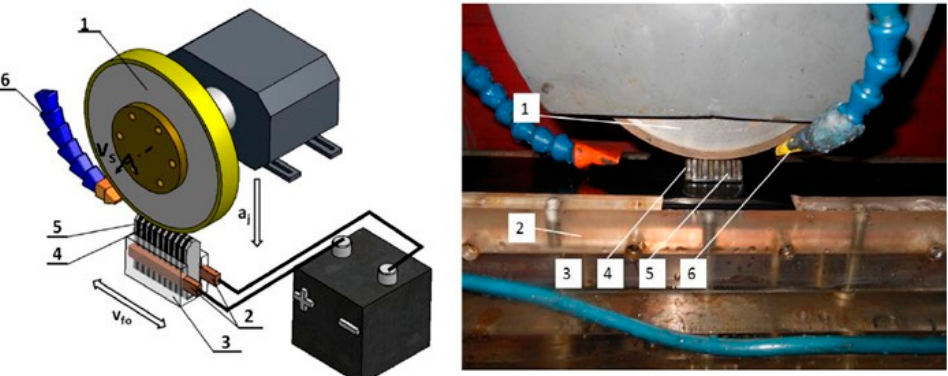
Figure 4. Diagram and view of the system for electrodischarge dressing of superhard grinding wheels with a segmental electrode: 1—grinding wheel, 2—copper graphite brush supplying voltage from the generator to the electrode, 3—vice, 4,5—segmental electrode, 6—dielectric supply nozzles.